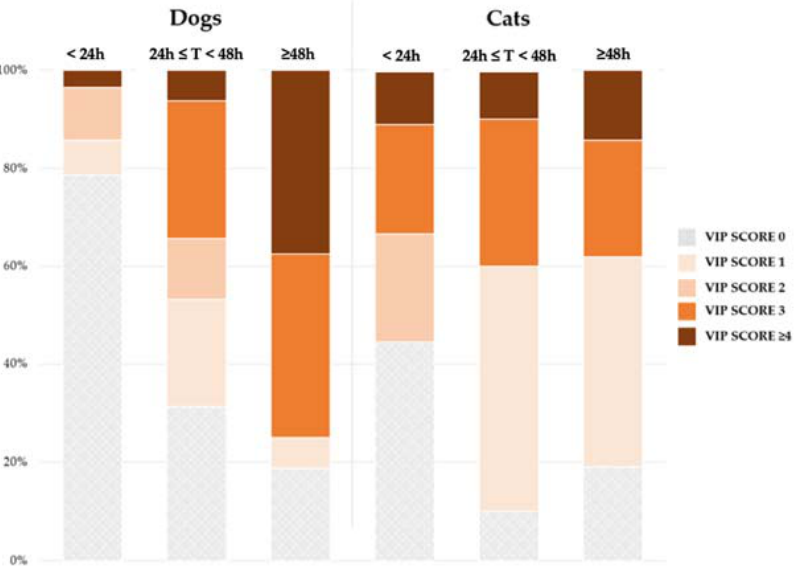
Figure 3. Distribution of the VIP scores according to the indwelling time of catheters. T: indwelling time; VIP: Visual Infusion Phlebitis.